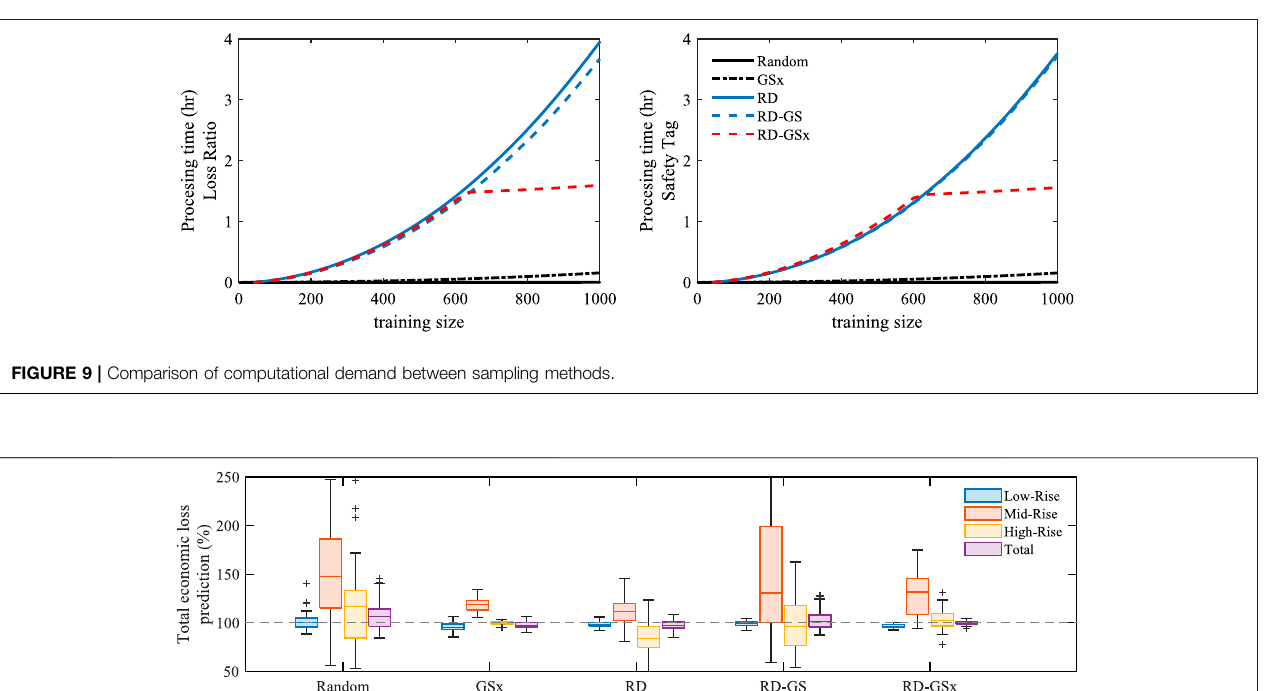
Frontiers in Built Environment |